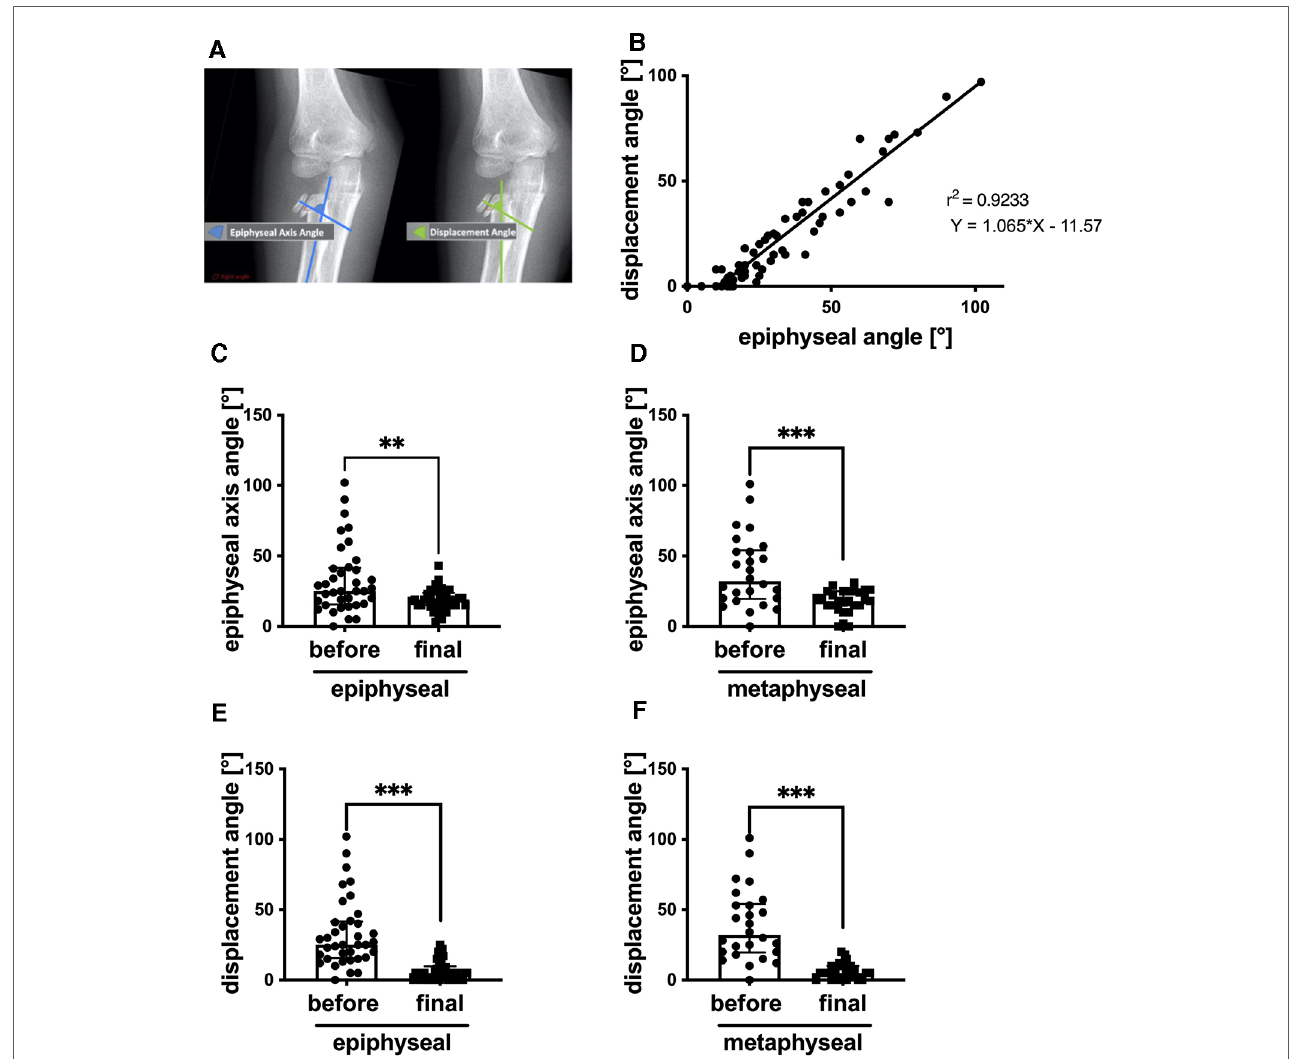
FIGURE 2 ( A ) Schematic illustration of displacement and epiphyseal axis angle. ( B ) Correlation of displacement and epiphyseal axis angles. ( C ) Epiphyseal axis angle before reduction of epiphyseal/head fracture and fi nal, n =37. ( D ) Epiphyseal axis angle before reduction of metaphyseal/neck fractures and fi nal, n =26. ( E ) Displacement angle before reduction of epiphyseal/head fracture and fi nal, n =37. ( F ) Displacement angle before reduction of metaphyseal/neck fractures and fi nal, n =27. ** p <0.001, *** p <0.0001, graphical presentation as median with interquartile range. For correlation analysis, simple linear regression with a 95% con fi dence interval was performed (Spearman test) with p -value